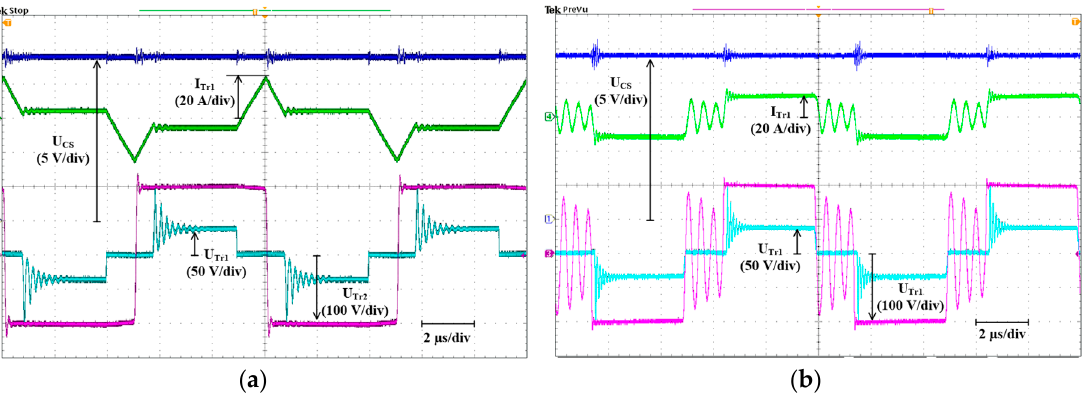
Figure 7. Operating waveforms in the S-SMC mode: boost ( a ) and buck ( b ). U CS = 24 V, P = 300 W.